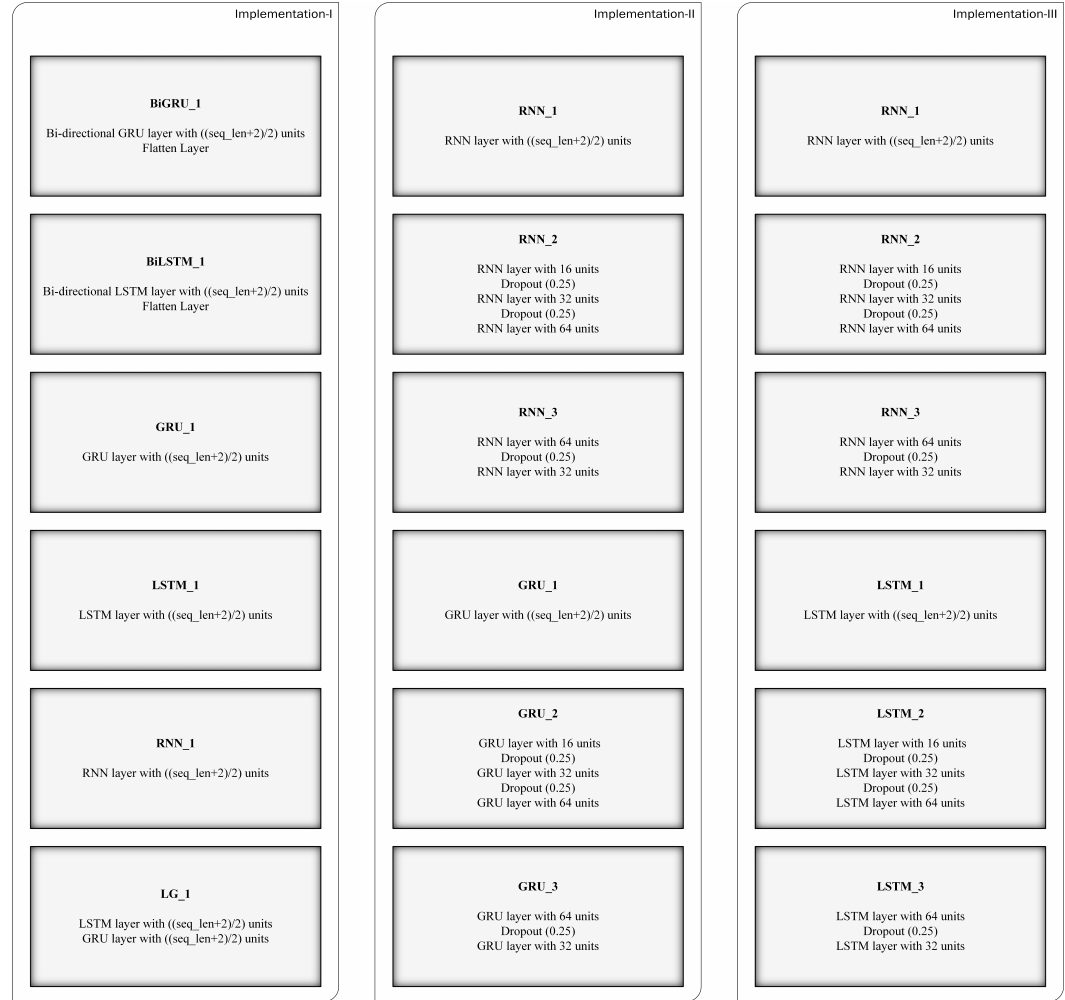
Figure 2. Ensemble models designed using three different